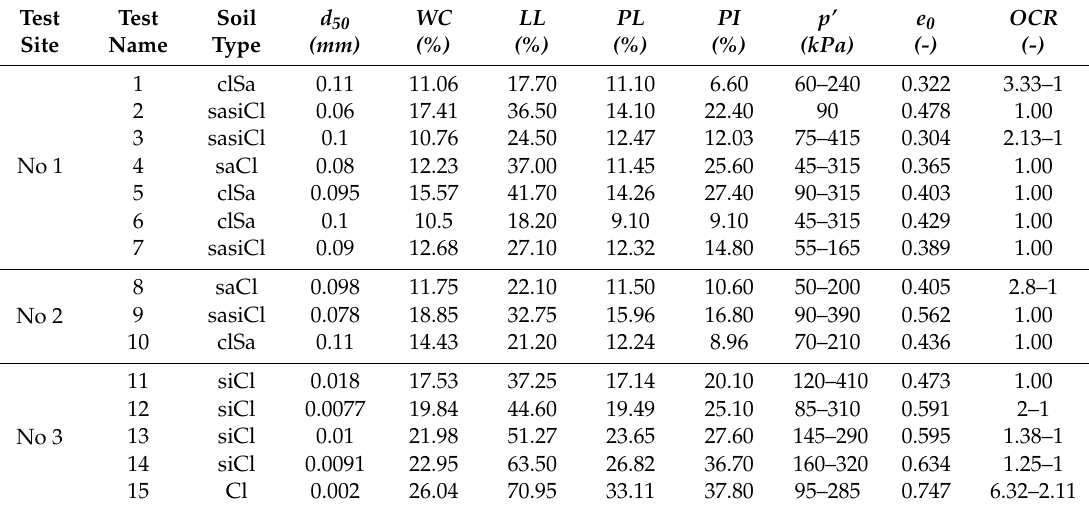
Table 3. Physical properties of test materials and the range of mean effective stress.